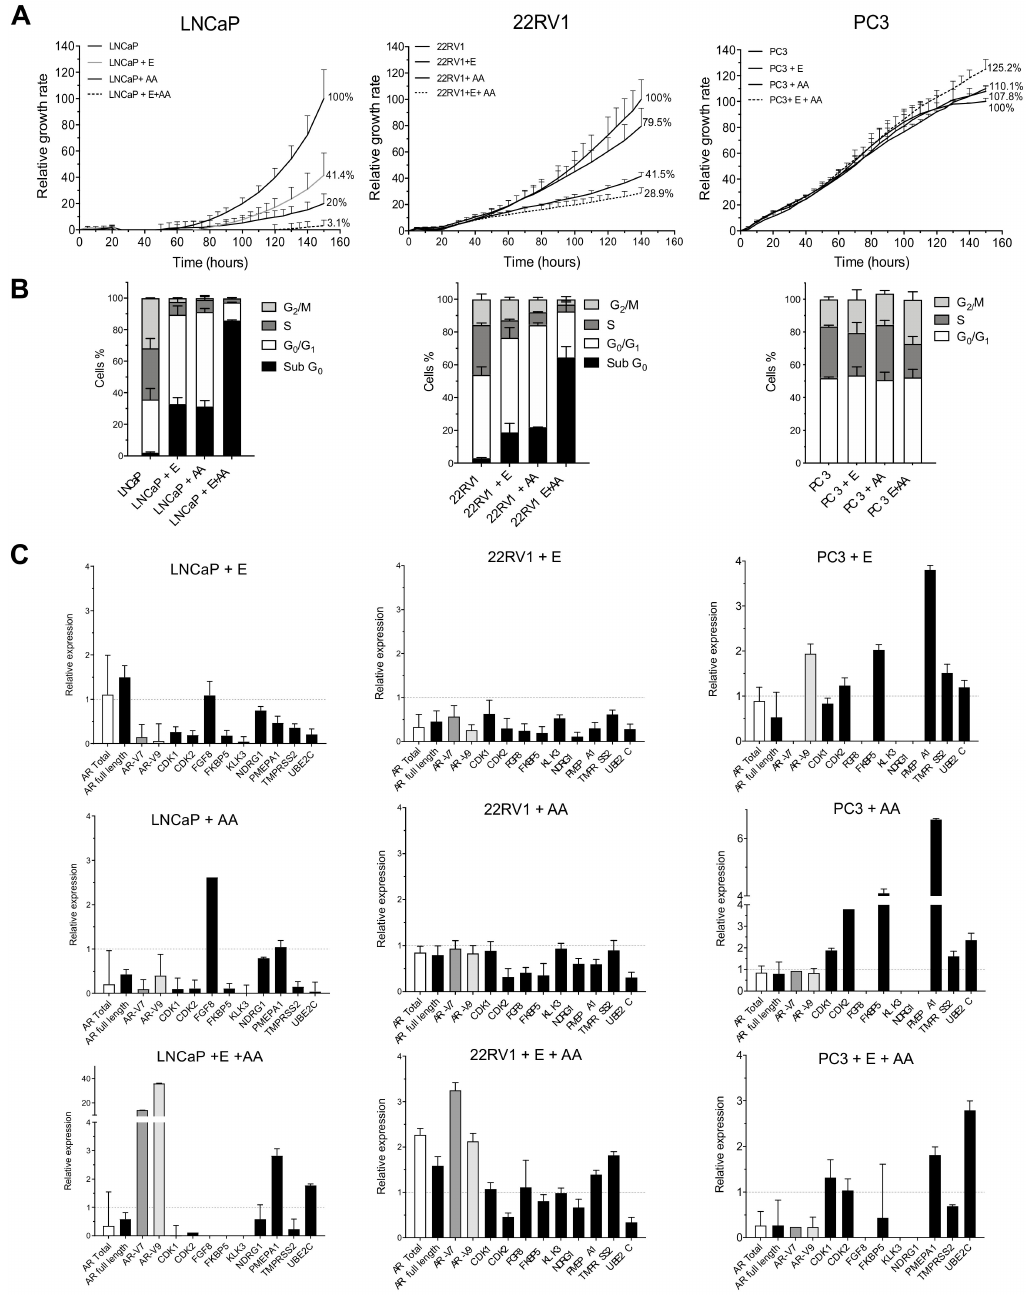
Figure 2. Response to Abiraterone (AA) and Enzalutamide (E) of the wild-type PCa cell lines. Proliferation, cell cycle and quantification of AR , AR-V7 , AR-V9 and AR target genes. PCa cells were treated for 5 days with 40 µ M Enz, 20 µ M AA or the combination (40 µ M Enz + 20 µ M AA). ( A ) Analysis of cell proliferation using xCELLigence. Results are normalized to untreated cells considering their final value after 5-day cultures 100%. Data shown correspond to the mean ± SD calculated from the quadruplicates made for each condition. ( B ) Cell cycle analysis after Enz, AA or the combination (E + AA) treatments for 5 days in LNCaP, 22RV1 and PC-3 cell lines. Stacked bar graphs show the percentages for each cell cycle phase; error bar corresponds to the SD calculated from the triplicates for each experimental condition. ( C ) qPCR analysis for AR isoforms and some of AR target genes after Enz, AA or the combination (E + AA) treatments for 5 days in LNCaP (left panels), 22RV1 (middle panels) and PC-3 (right panels). The results are shown after normalization with respect to endogenous control (GADPH) and referenced to the control group (wild-type untreated cells). The error bars correspond to the SD calculated from